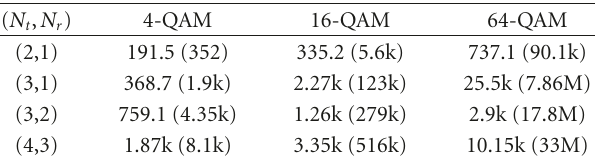
Table 1: The average number of flops for planar detection with J = 0. The numbers in brackets indicate the required complexity for a BF detector.